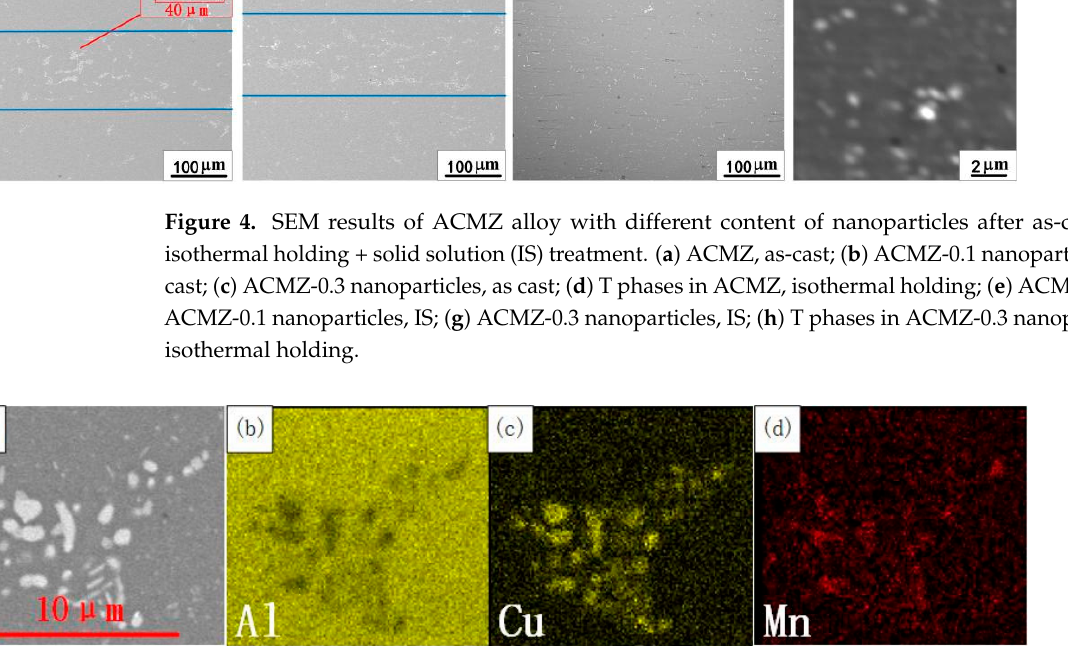
Figure 5. The EDS map of the residual part after solid solution, ACMZ. ( a ) SEM area of residual structure after solid solution; ( b ) Al in this area; ( c ) Cu in this area; ( d ) Mn in this area. Figure 6. Scanning areas of linescan in α (Al) at different positions of as-cast ACMZ and ACMZ-0.1 nanoparticles, and the red lines are the paths of line scanning. ( a ) The central segregation region of ACMZ; ( b ) The surface of ACMZ; ( c ) The central segregation region of nanoparticles; ( d ) The surface of ACMZ-0.1 nanoparticles.